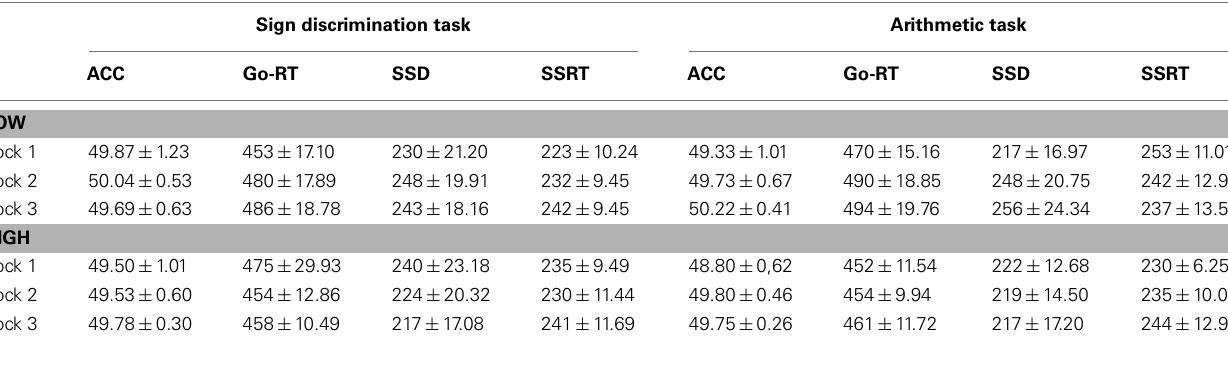
Table 1 | Mean ( ± SEM) percentage (%) accuracy (ACC), motor reaction times for go-signals (go-RT), stop-signal delays (SSD), and stop-signal reaction times (SSRT) for the three blocks of the stop-signal task following the sign discrimination task and the arithmetic task in Experiment